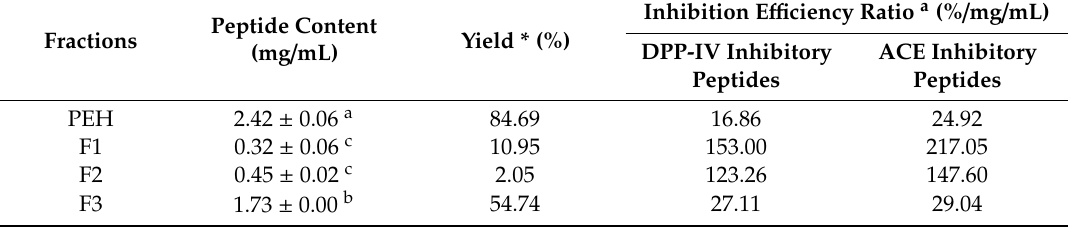
Table 4. Inhibitory activity, peptide content, yield, and inhibitory e ffi ciency ratio of pepsin hydrolysate and peptide fractions.